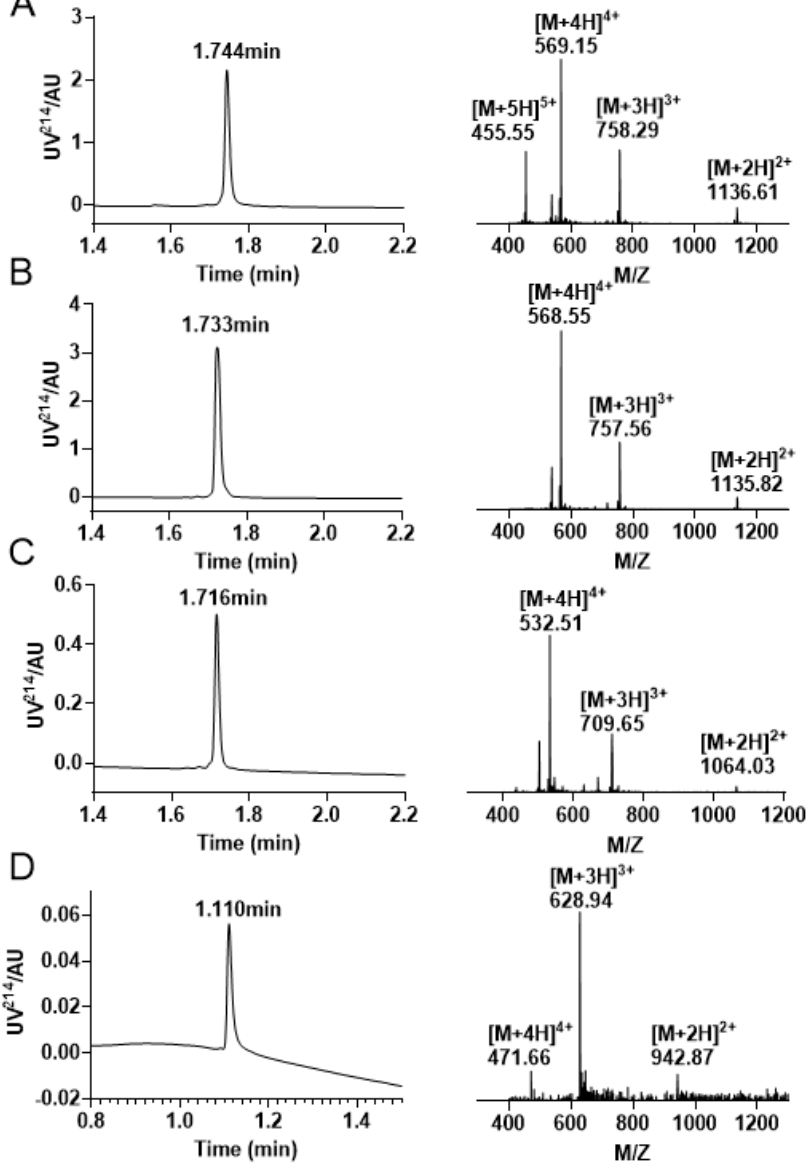
Figure 7. Analytical RP − UPLC chromatograms and ESI-MS Spectra of each stage of the Trt/Acm/Mob folding. ( A ) The linear peptide of KIIIA with a retention time of 1.744 min and a mass of 2271.87 Da. ( B ) The KIIIA has one disulfide bond between Cys1 and Cys15 with a retention time of 1.733 min and a mass of 2269.68 Da. ( C ) The RP − UPLC and ESI–MS profiles of KIIIA with Cys1 —Cys15/Cys2 —Cys9 linkage. The retention time is 1.716 min, and the mass is 2125.95 Da. ( D ) Chromatograms and mass spectra of the final oxidation results with a retention time of 1.110 min and a mass of 1883.82